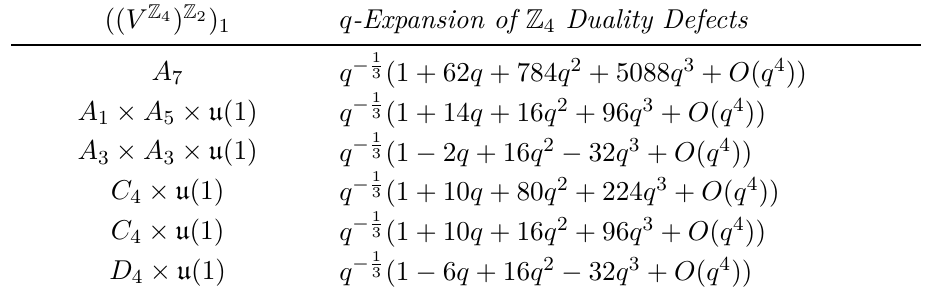
while the rest come from ν (4) 2 3